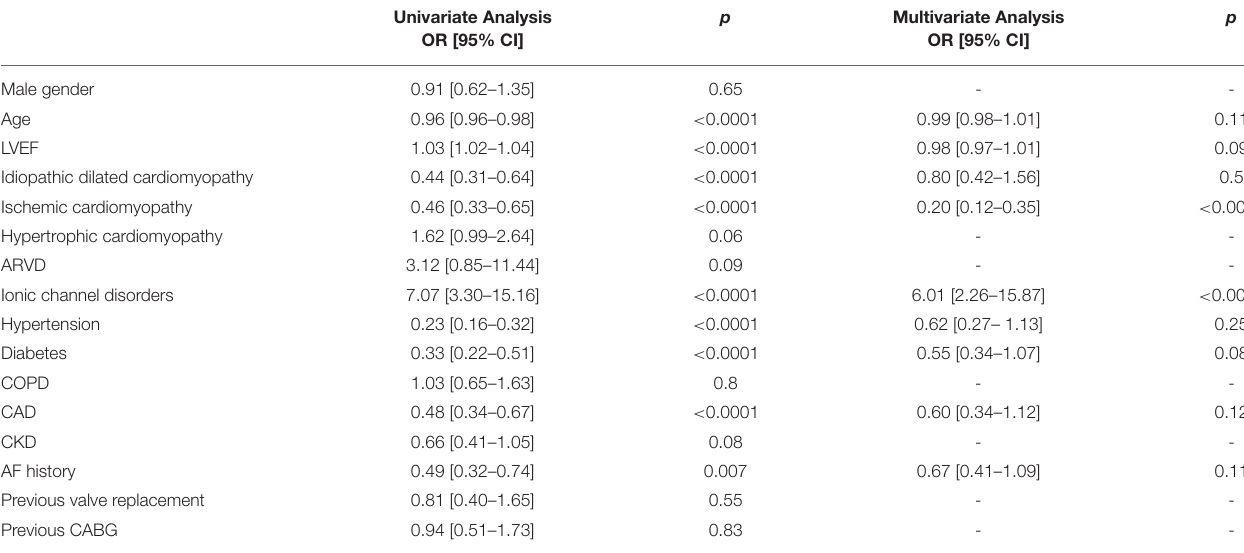
TABLE 2 | Association between S-ICD implantation and clinical covariates: univariate and multivariate analysis.